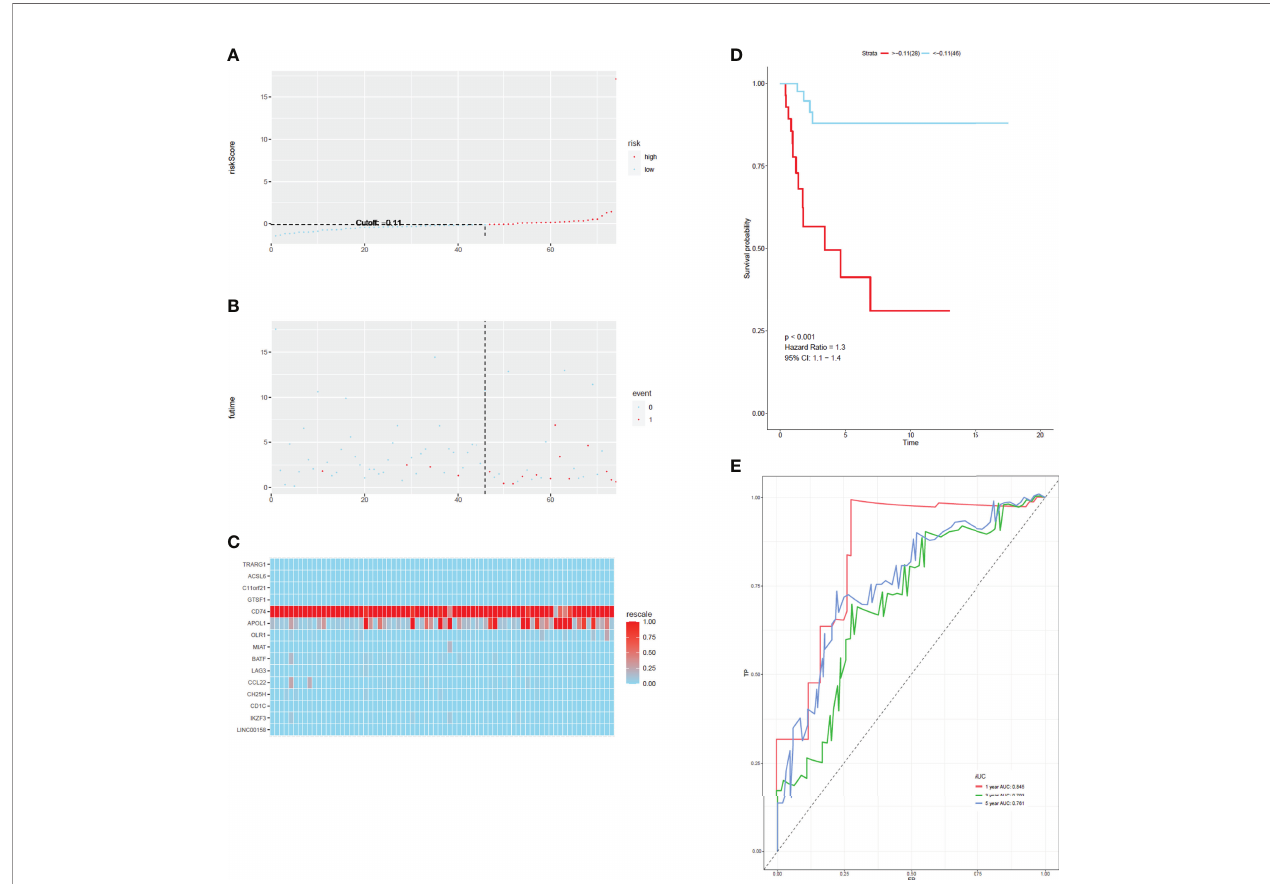
FIGURE 7 | The distribution of time-dependent ROC curves and Kaplan – Meier survival based on the integrated classi fi er in the train cohort. (A) The distribution of risk score in train cohort. (B) The survival duration and status of patients in train cohort. (C) A heatmap of immune related genes in the classi fi er in train cohort. (D) Kaplan – Meier curve for patients with cervical cancer in train cohort. (E) ROC curve for cervical cancer in train